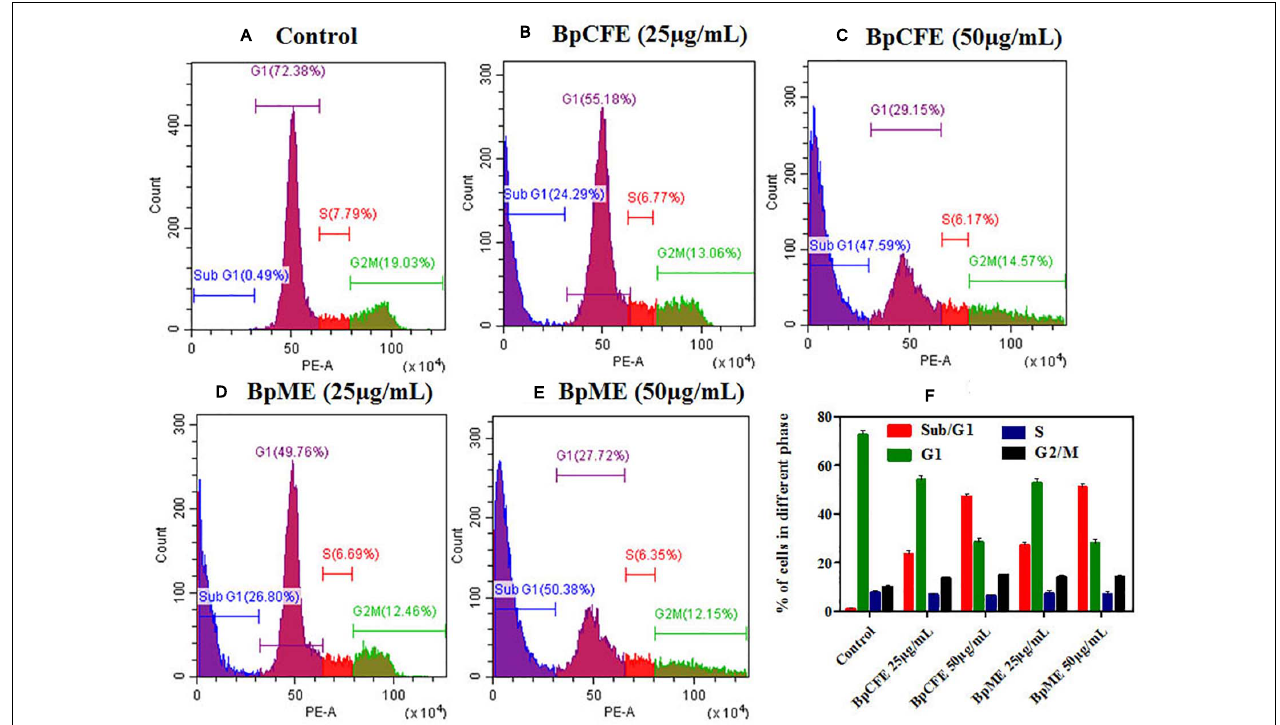
FIGURE 8 | Cell cycle analysis of HeLa cells treated with Bp culture extract estimated using propidium iodide staining by flow cytometry analysis. (A) Untreated (B) culture filtrate extract (25 µ g/ml), (C) culture filtrate extract (50 µ g/ml), (D) mycelial extract (25 µ g/ml), and (E) mycelial extract (50 µ g/ml). (F) Statistical analysis showing the percentage of cell cycle in each phase. The experiments were conducted three times, and results are obtained from mean ± SD.